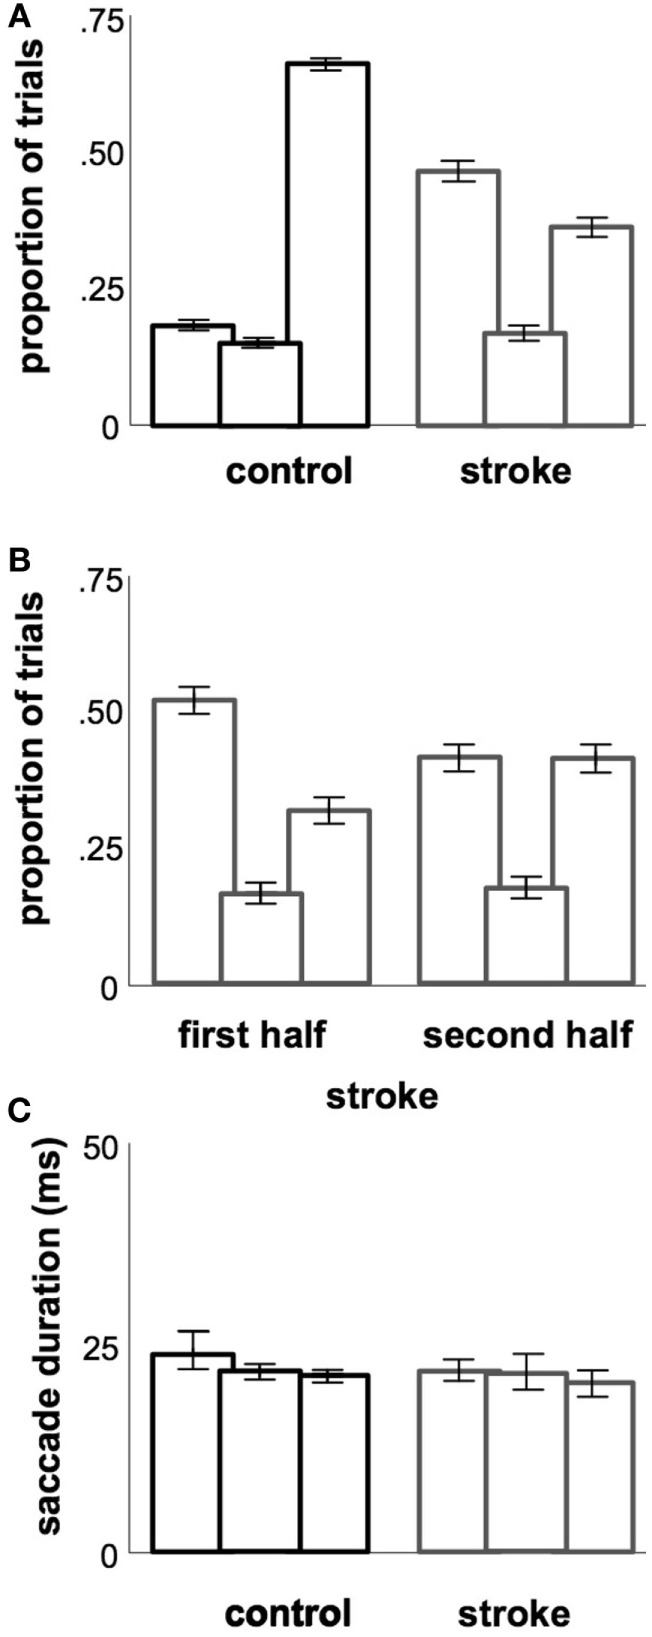
Temporal metrics. (A) Proportions of saccades occurring in each of the three latency ranges (each triple is ordered, from left to right: anticipatory, early, regular). (B) Proportions of saccades occurring in each latency range, as in (A), but split between the first and second halves of each stroke subject’s session. (C) Average saccade durations occurring in each of the three latency ranges. Error bars (included in all plots): 95% confidence range for the mean across subjects.